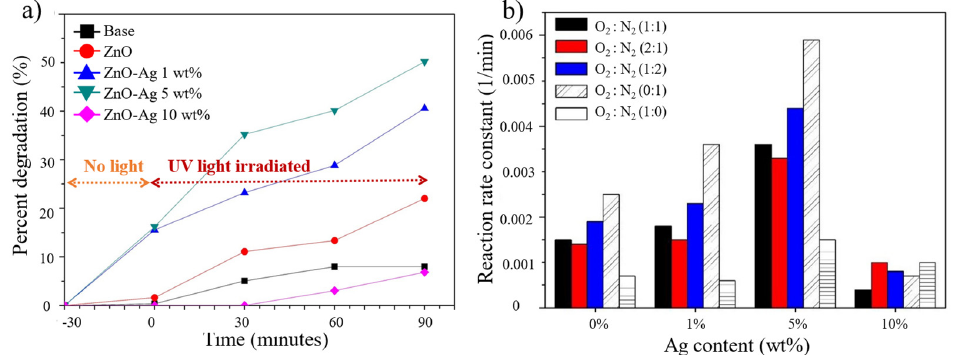
Figure 7. ( a ) Photocatalytic degradation percentage of the pollutants using ZnO-Ag synthesized by pure nitrogen as the carrier gas and ( b ) reaction rate constant of the produced nanoparticles under UV light irradiation.